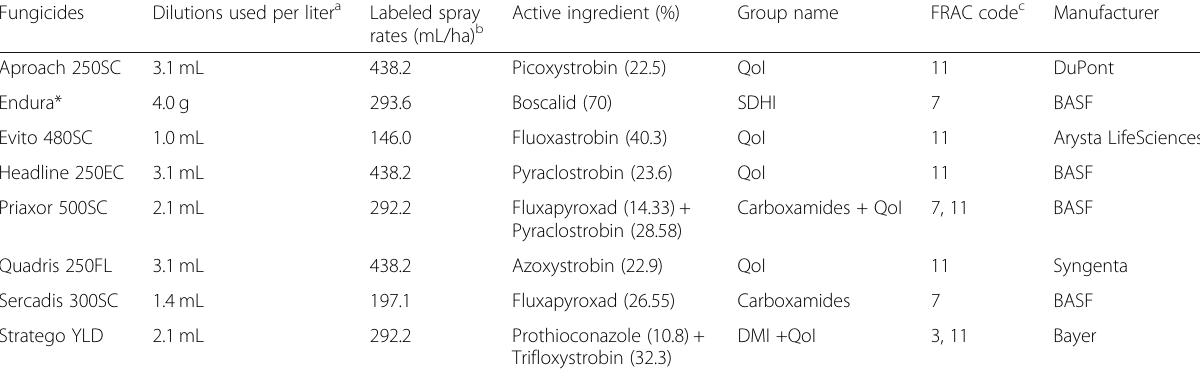
Table 4 List of foliar fungicides used in seed treatment tests in field against damping-off caused by Pythium ultimum var. ultimum in a soybean field artificially inoculated